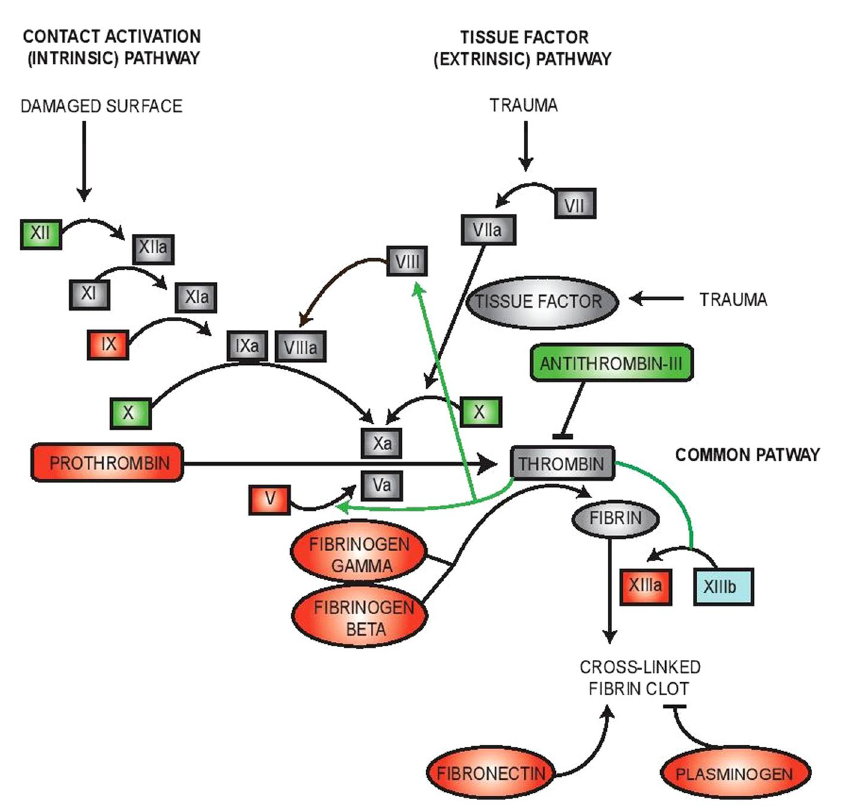
Figure 4. Key components of the intrinsic coagulation cascade are down-regulated in Epac1 − / − plasma. Plasma samples from WT (n = 6) and Epac1 − / − (n = 7) mice were analyzed by label-free quantitative proteomics. The differentially expressed proteins in the plasma samples were involved in the coagulation cascade and formation of fibrin clots. Down-regulated proteins are red, up-regulated are blue. Green, no altered regulation. Grey, not quantified. Thrombin signaling in this cascade is marked with green